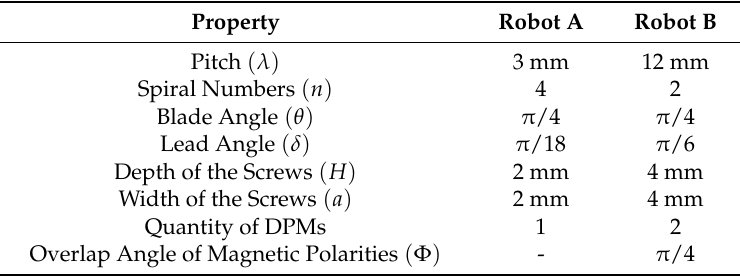
Table 3. Special design of the two capsule robots.